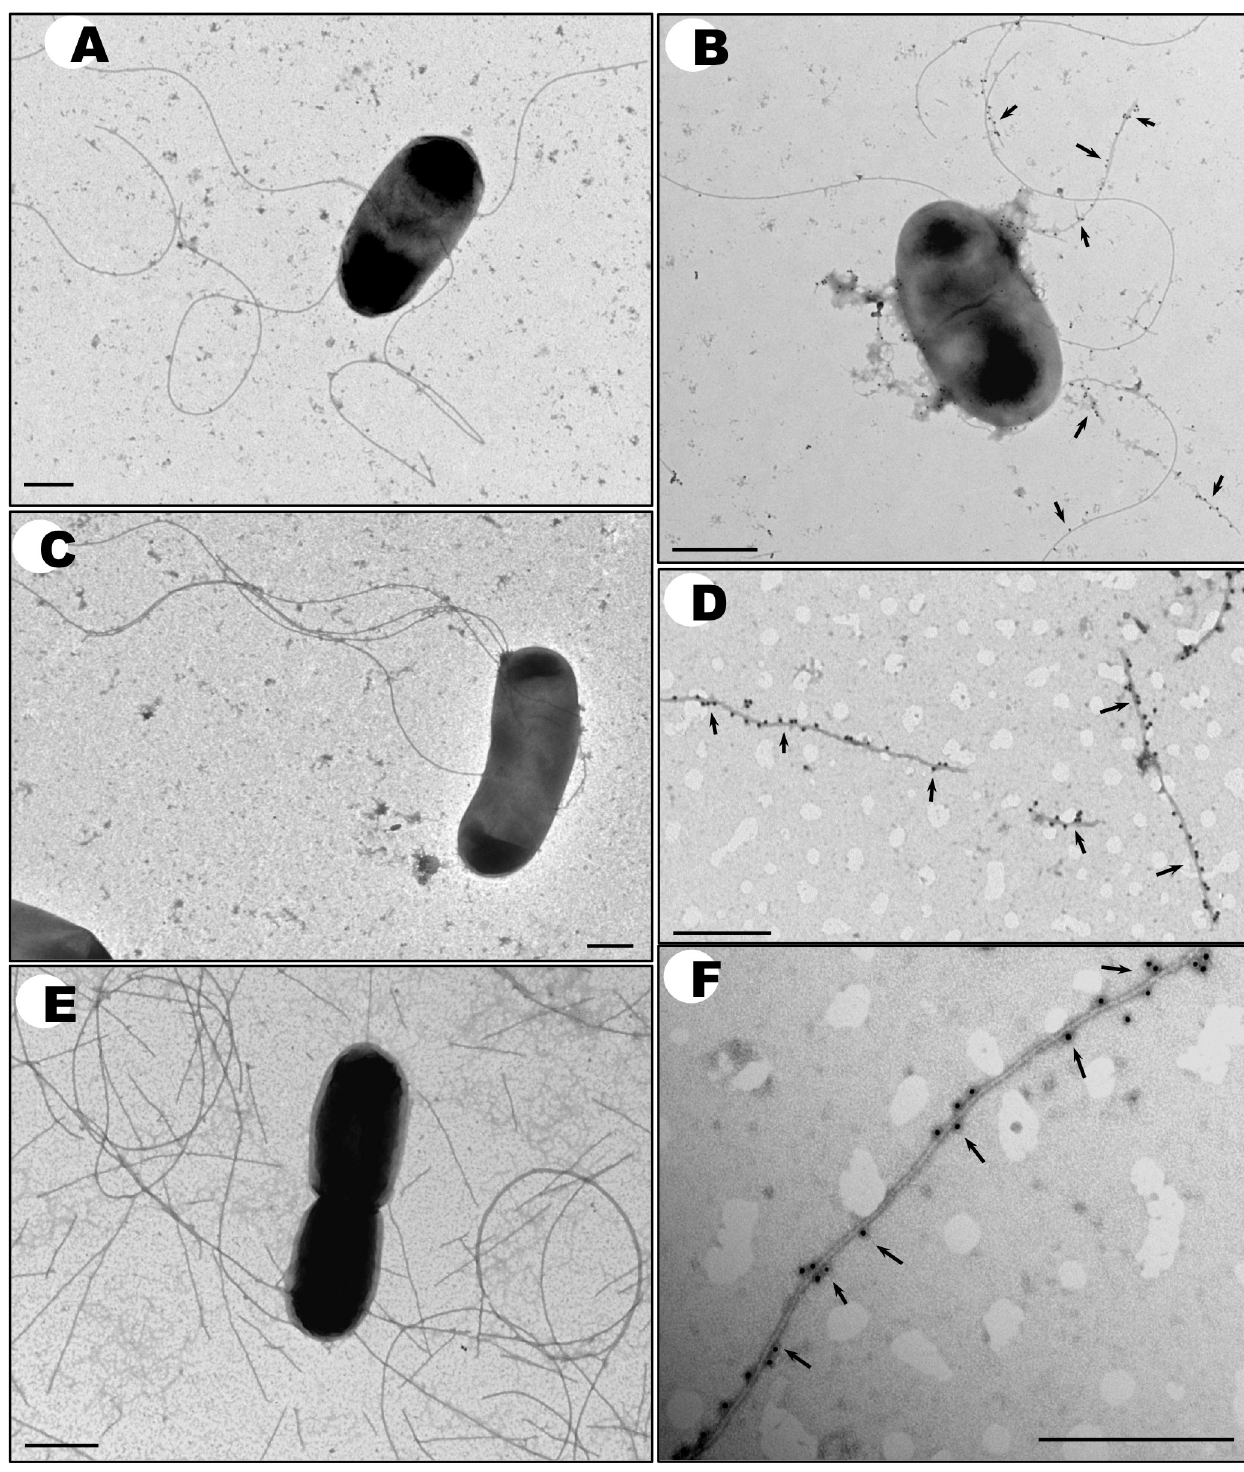
Fig 7. Detection of the RSP protein by immunogold electron microscopy. The plasmid-free SL1344 strain is shown in panel (A). The strain SL1344 (R27) is in panels (B, D-F). The strain SL1344 (R27 Δ rsp ) is shown in panel (C). Samples in panels (A-D and F) were labeled with rabbit anti-RSP polyclonal antibodies and goat anti-rabbit IgG conjugated to 12 nm gold particles. The control experiment is shown in panel (E) and was labeled with goat anti-rabbit IgG conjugated to 12 nm gold particles in the absence of a specific antibody. Arrows point to the RSP protein associated with the flagella. Bars represent 0,5 μ